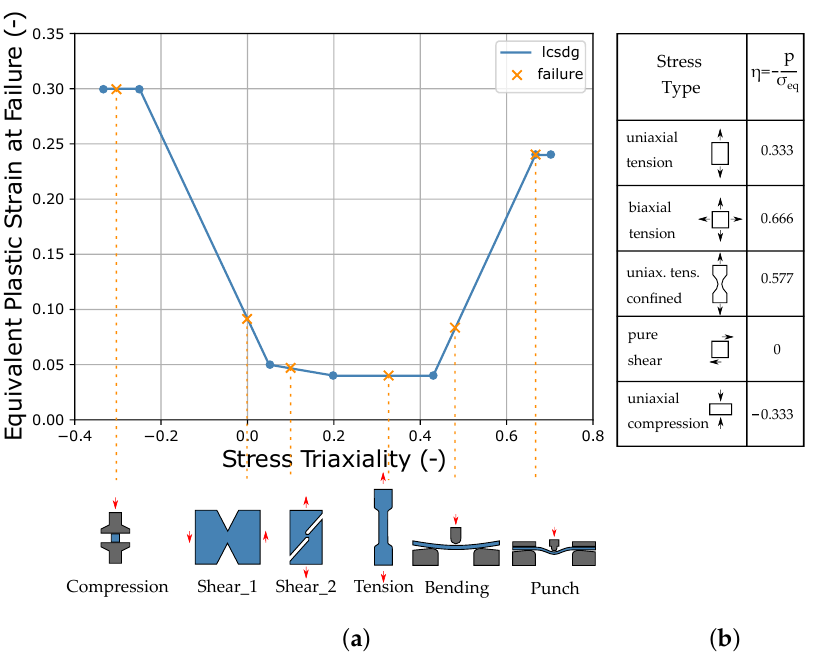
Figure 3. Equivalent plastic strain at failure vs. triaxiality curve with corresponding tests used in this paper ( a ) and stress state-dependent triaxialities ( b ).